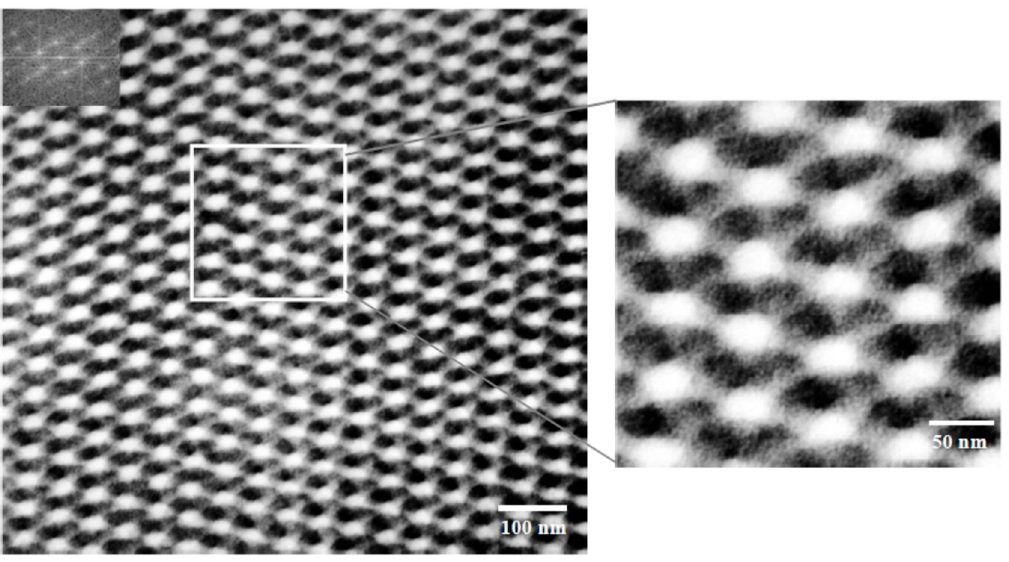
Figure 3. Bright ‐ field TEM image, and a “magnified area” for enhancing details, exhibiting approximately a [111] projection. The insert at the upper left of the TEM image is the corresponding FFT. White areas correspond to PS domains, grey areas to 3,4-PI blocks and the black areas to the PB FFT. White areas correspond to PS domains, grey areas to 3,4 ‐ PI blocks and the black areas to the PB segments after staining with OsO 4 for approximately 30 segments after staining with OsO 4 for approximately 30 min.